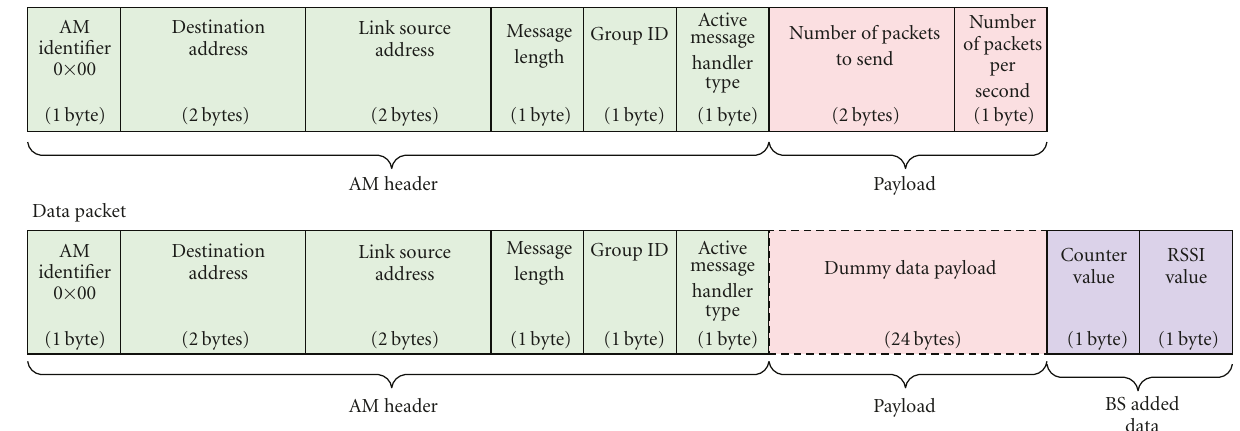
Figure 1: Packet structures for control and data packets.